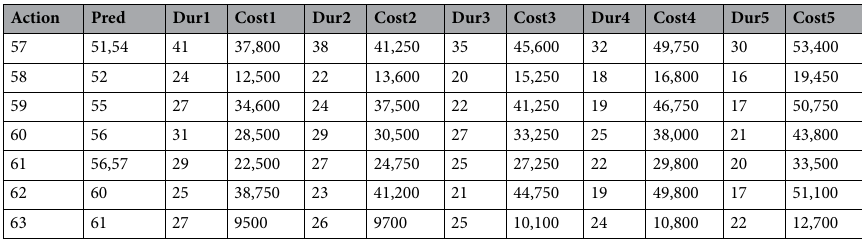
Table 8. Data for the 63 activity time–cost trade-off problem.